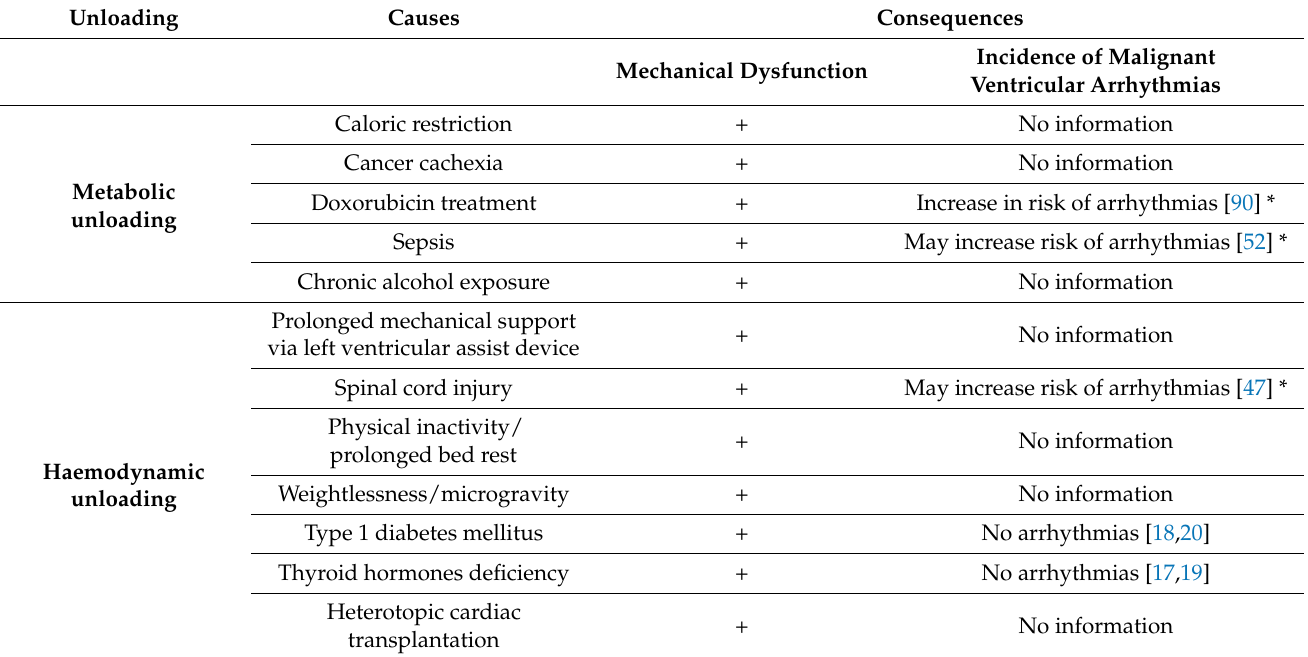
Table 1. Conditions leading to cardiac atrophy and incidence of cardiac